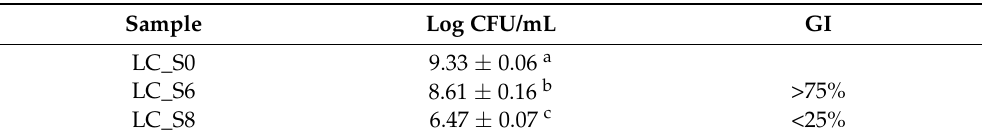
Table 2. Plate counts (Log CFU/mL) and GI of sonicated and not-sonicated cells of Lacticaseibacillus casei ATCC 393. LC_S0: not-sonicated cells, control; LC_S6: treatment at 57 W with 50% DC for 6 min; LC_S8: treatment at 57 W with 50% DC for 8 min.